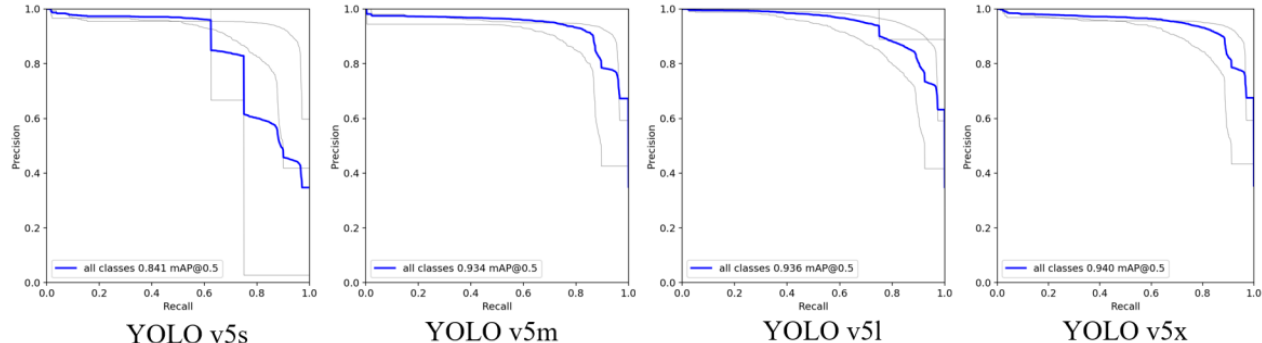
Figure 10. P-R curves of the four models during the training.